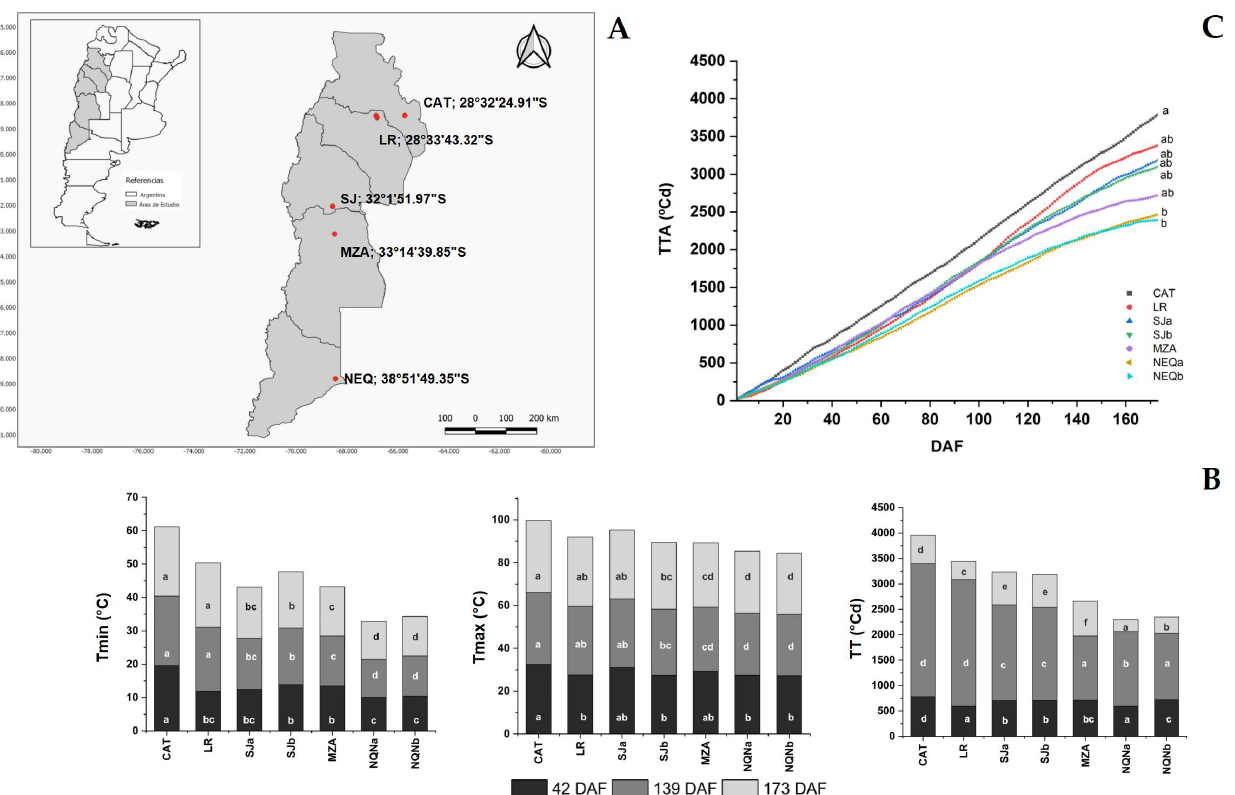
Figure 1. ( A ) Map of the study area in Argentina covering multiple provinces along the latitudinal growth gradient (Catamarca (CAT) 2014/15, La Rioja (LR), 2015/16, San Juan (SJa), 2014/15, San Juan (SJb), 2015/16, Mendoza (MZA), 2015/16, Neuquén (NQNa), 2014/15 and Neuquén (NQNb), 2015/16). The geographical location of the sampled sites is indicated in red. ( B ) Average minimum and maximum temperatures and accumulated degree days detected at 42, 139 and 173 DAF for the different environments; ( C ) accumulated thermal time (TT, °C d) registered from full flowering to fruit veraison in the seven analyzed growing environments. Different letters correspond to significant differences at p < 0.05 among environments for a given phenological stage.